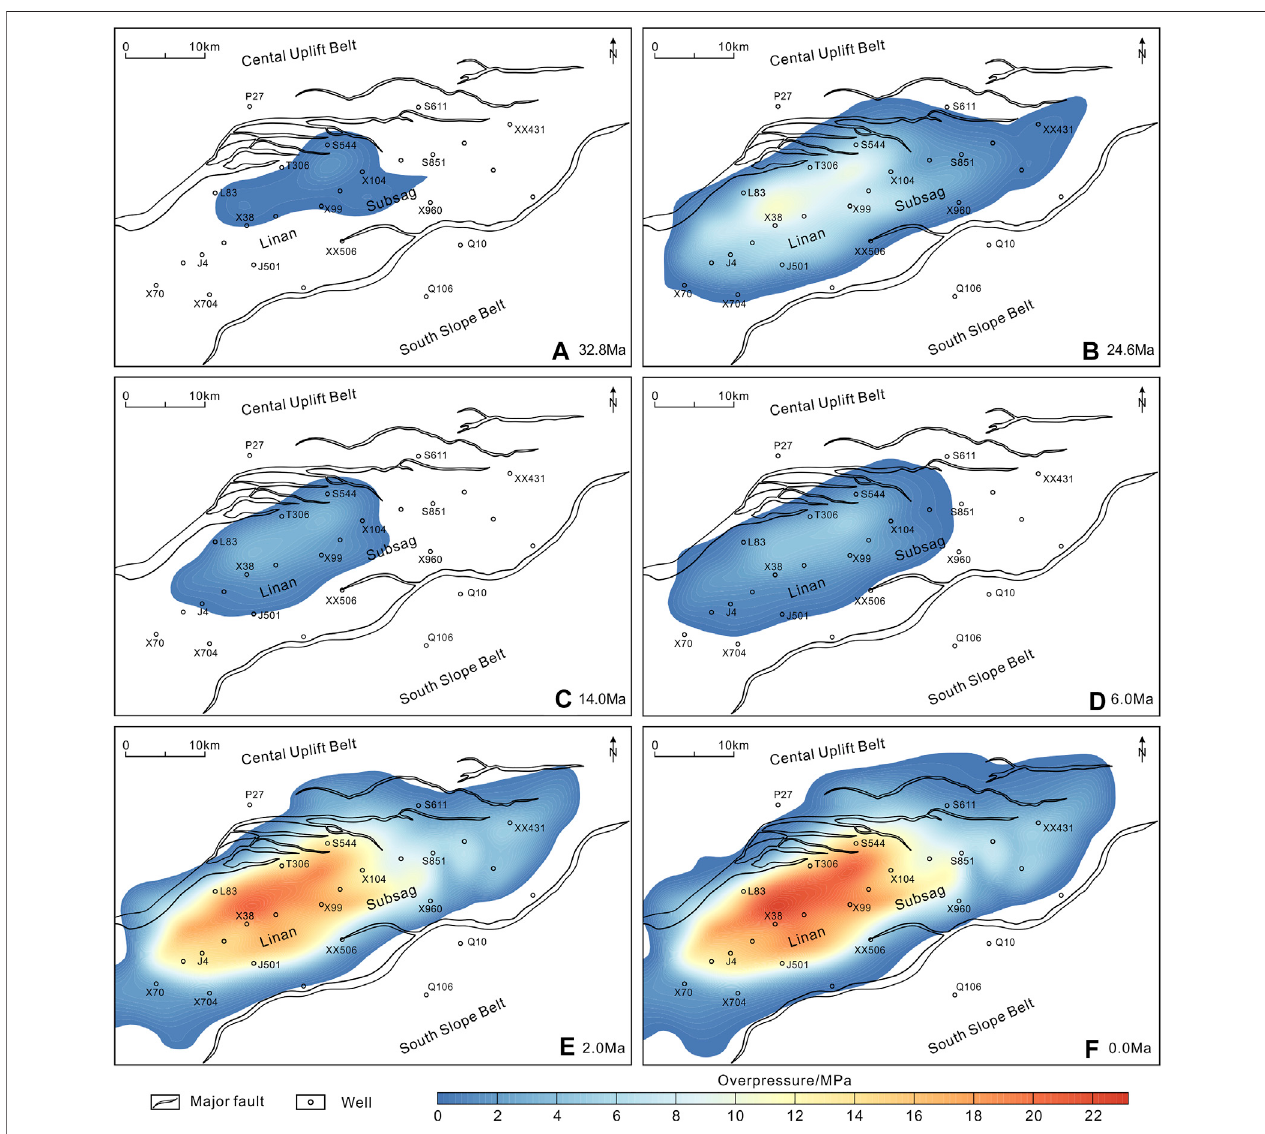
FIGURE 10 | Evolution of the overpressure of Es3l in the Linnan Sag obtained from 3D basin modeling results. (A) 32.8 Ma, (B) 24.6 Ma, (C) 14.0 Ma, (D) 6.0 Ma, (E) 2.0 Ma, (F) 0.0 Ma.